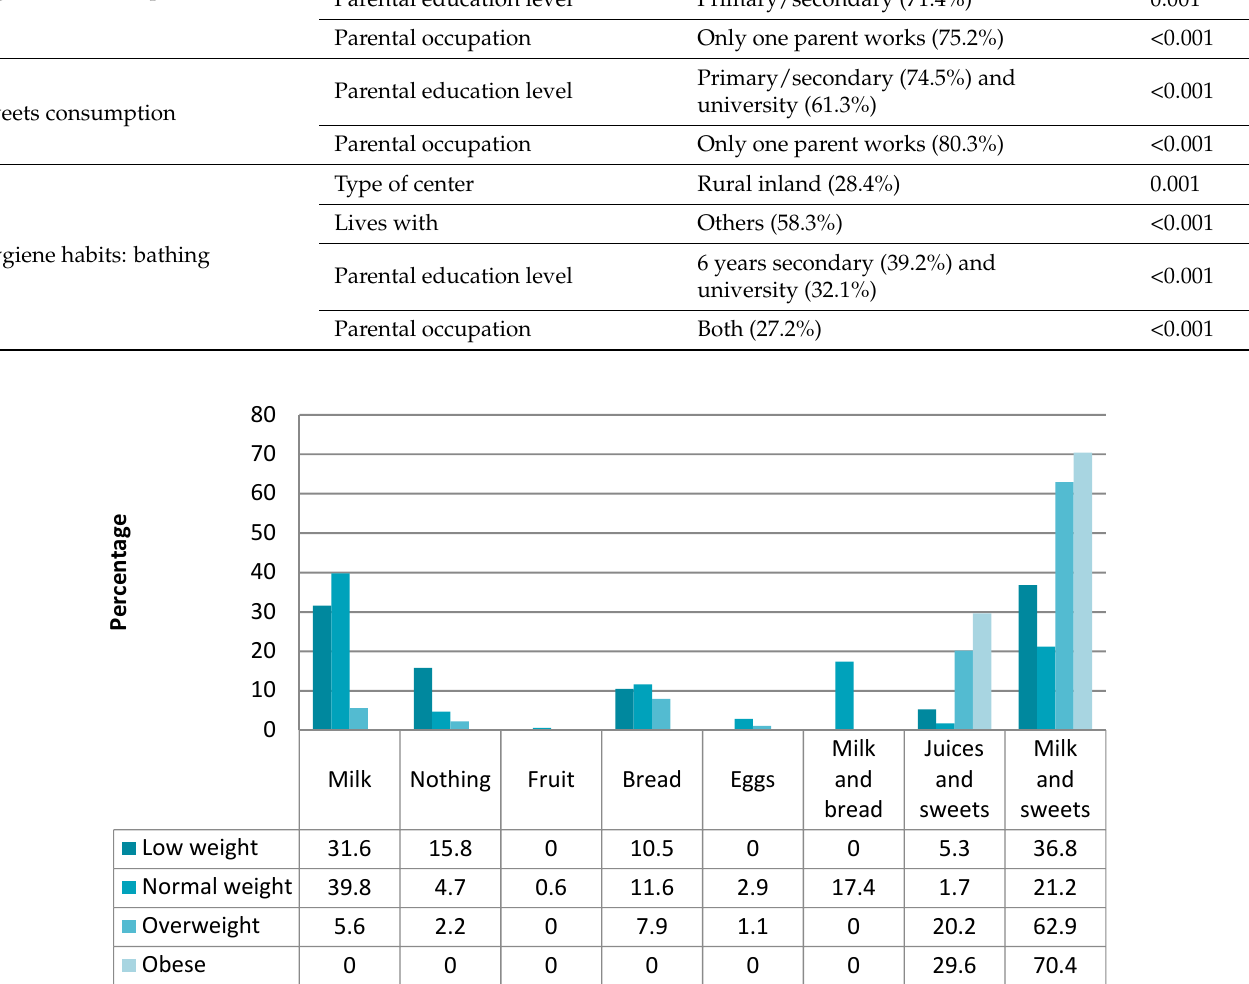
Figure 4. Food consumption at breakfast according to BMI before the intervention.